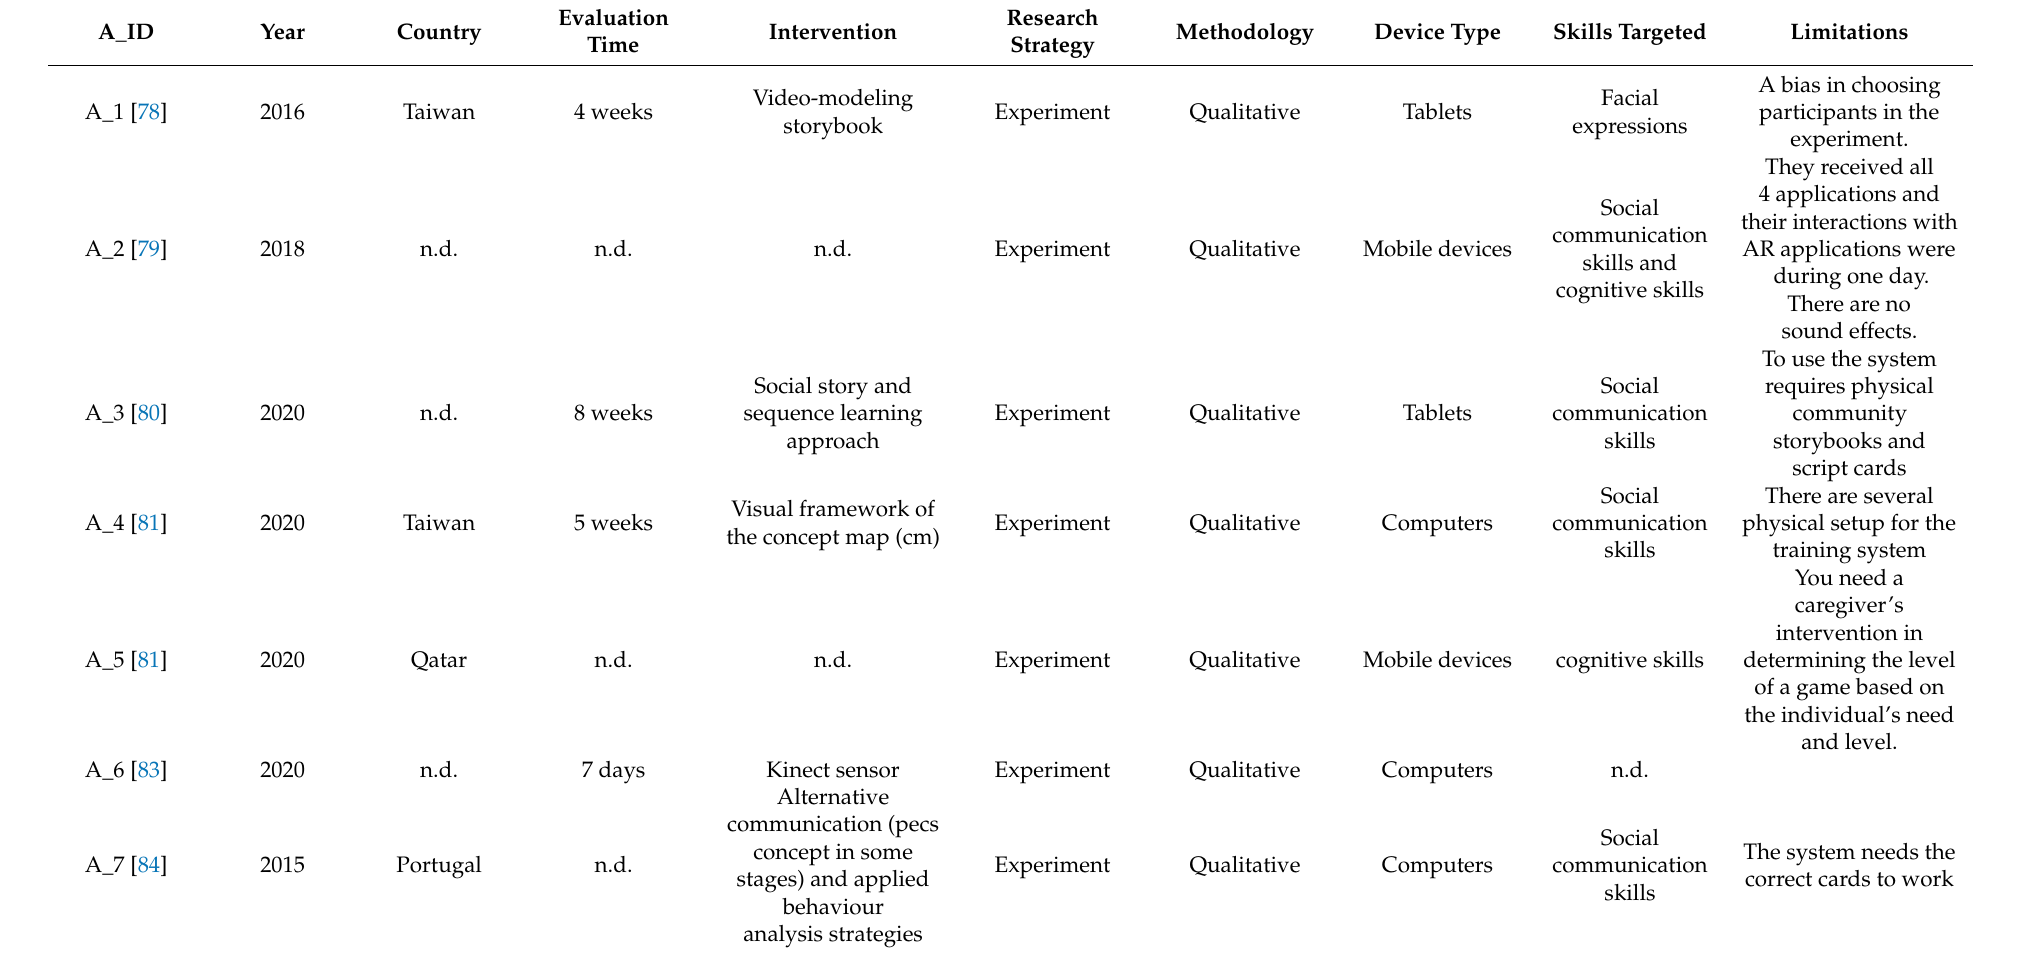
Table 8. Related work of using AR with